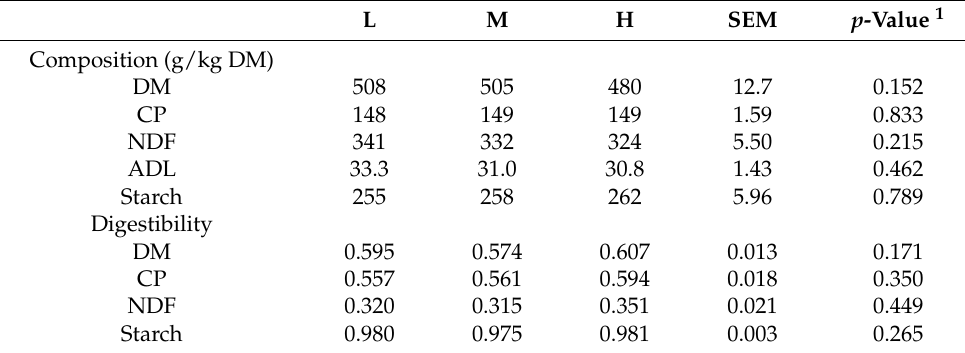
Table 4. Total mixed ration (TMR) average chemical and physical characteristics, total tract di- gestibility and coefficient of variation for farms belonging to low (L), medium (M) and high (H) production classes. L M H SEM p -Value 1 Composition (g/kg